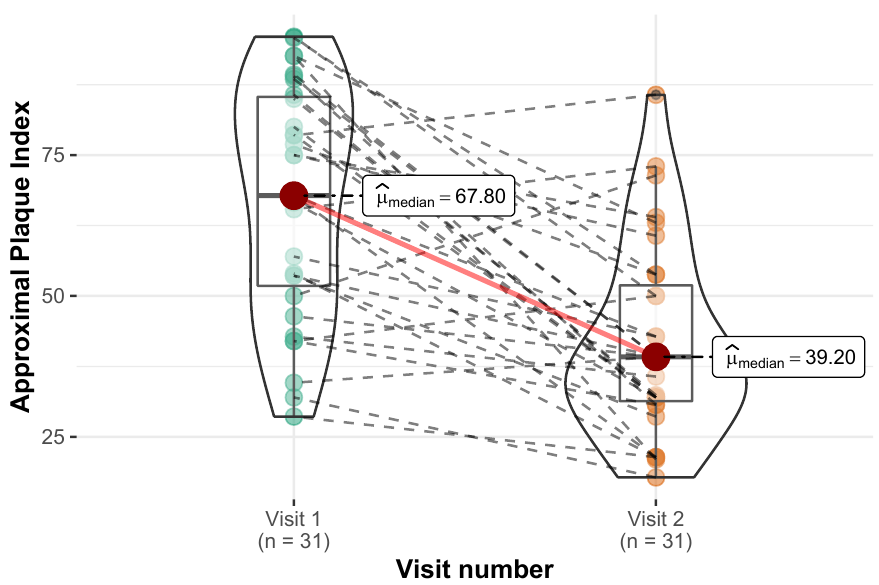
Figure 3. Approximal plaque index vs. Visit variable with differences in means statistical